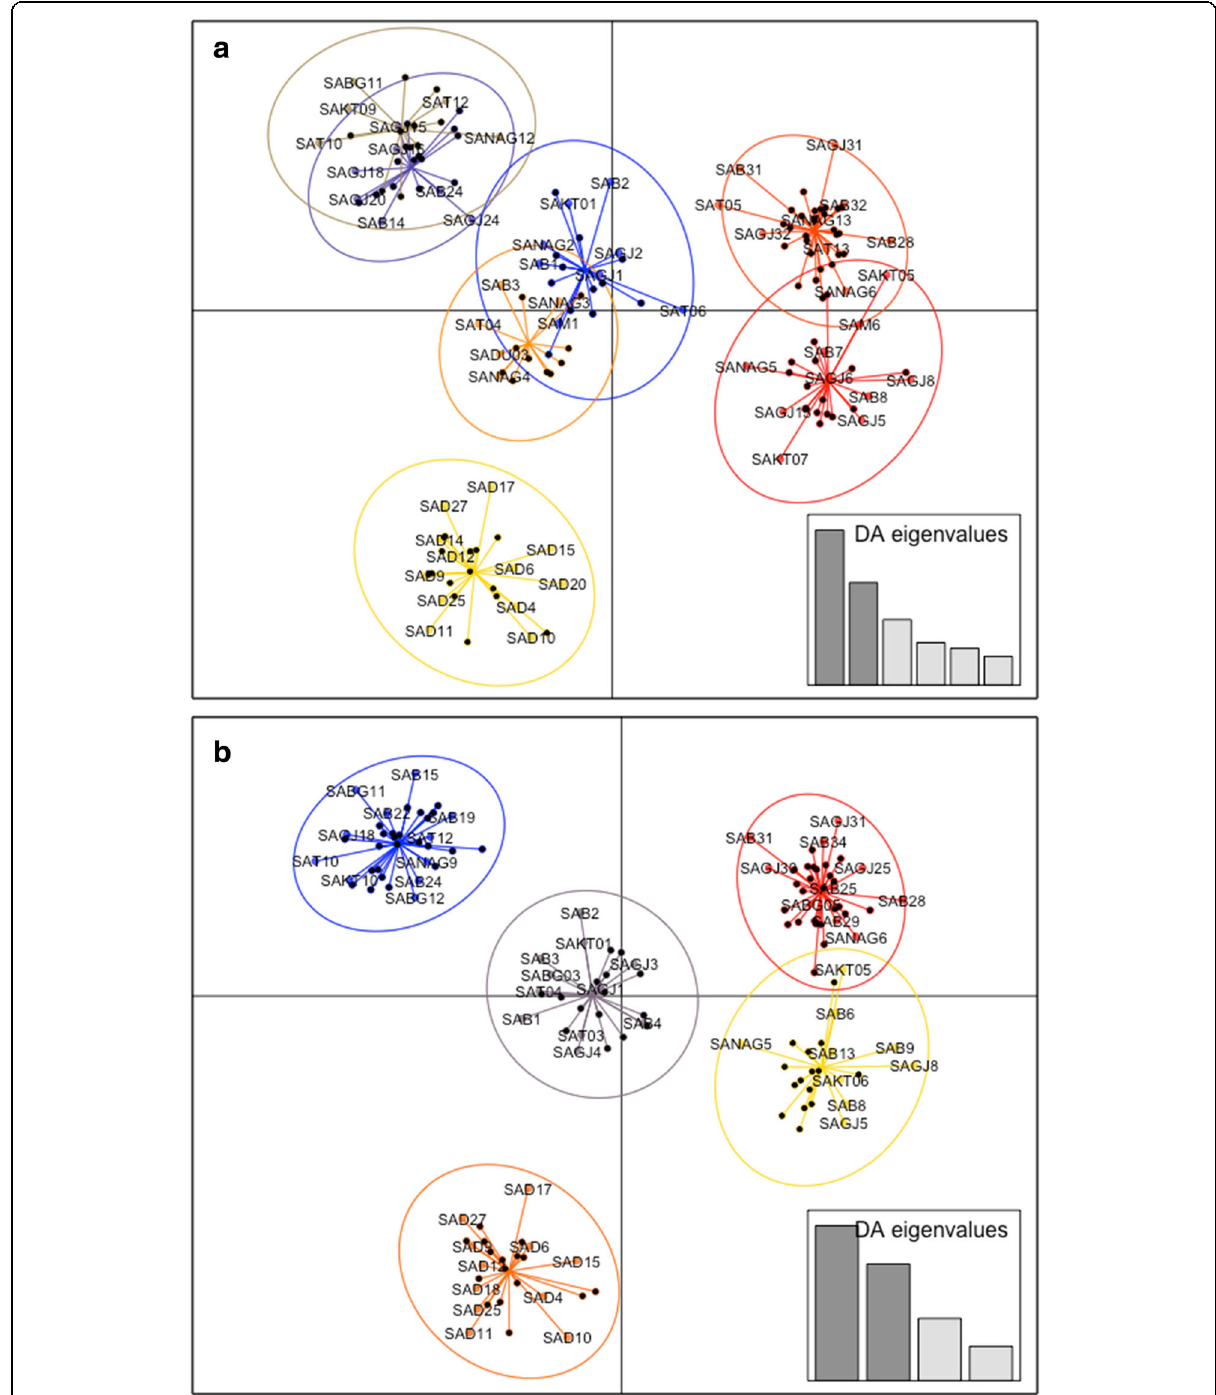
Fig. 5 Scatterplot showing S. asoca DAPC analysis for the first two principal components. Inset shows discriminant analysis eigenvalues in histogram. a All 160 accessions. b Seven wild